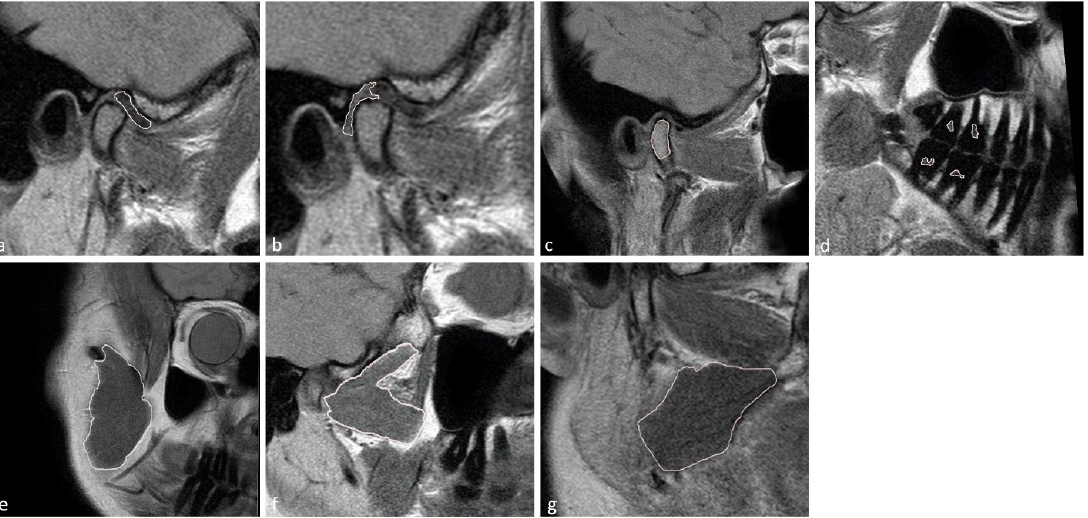
Figure 1. Samples of stomatognathic anatomical structure segmentation for the ( a ) disk; ( b ) retrodiscal tissue; ( c ) bone marrow of the condyloid process; ( d ) pulp; ( e ) m. masseter; ( f ) m. pterygoideus lateralis; and ( g ) m. pterygoideus medialis.